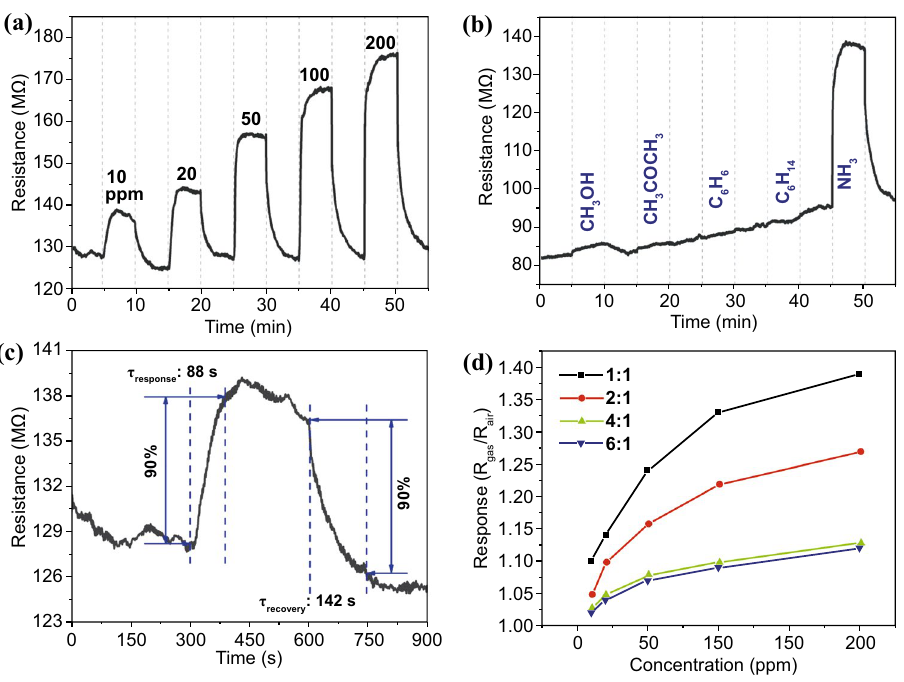
Fig. 6 Gas sensing performance at room temperature: a resistance variation of BG/Ti 3 CN (1:1) sensor to different concentrations of ammonia, b resistance variation of BG/Ti 3 CN (1:1) sensor to different gases of 100 ppm, c response and recovery time of BG/Ti 3 CN (1:1) to 10 ppm ammo- nia, and d correlation between gas response and ammonia concentration of BG/Ti 3 CN by different ratios